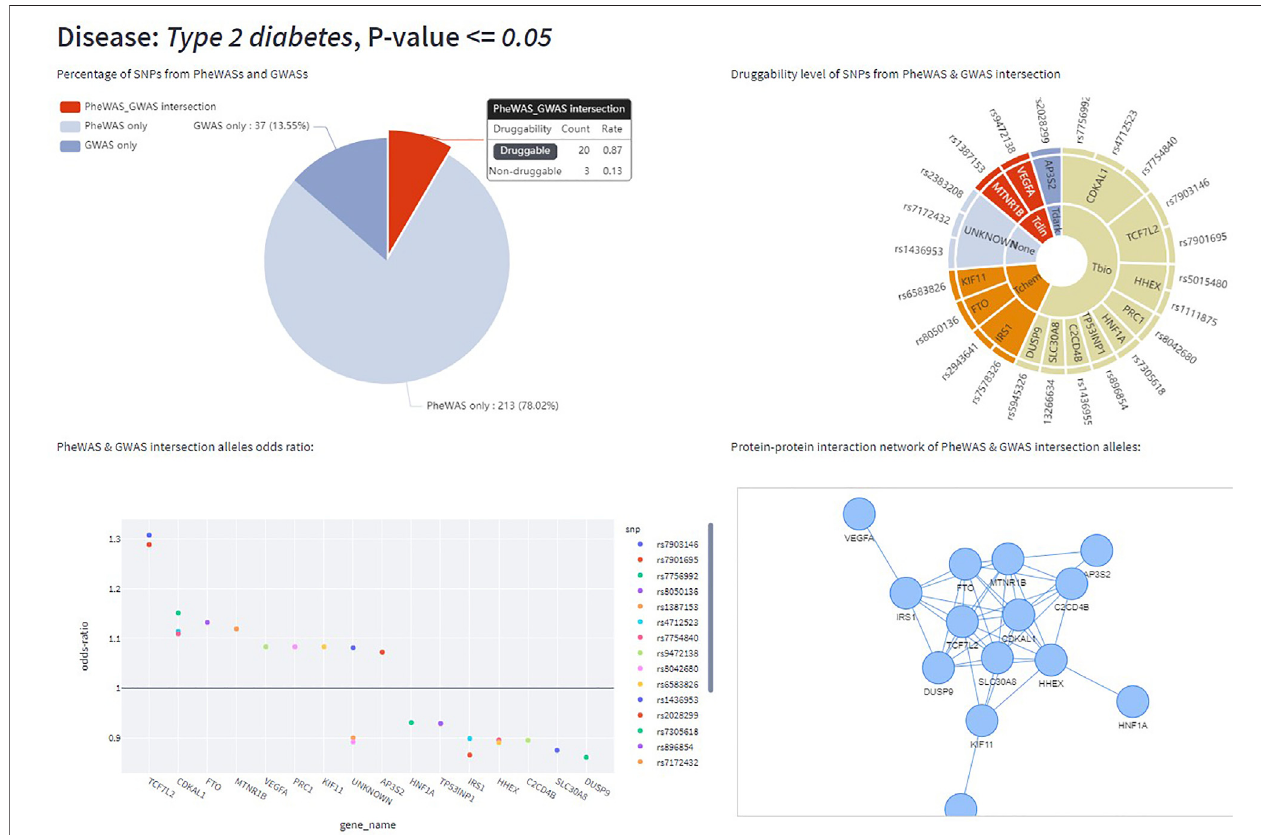
FIGURE 4 | The StarGazer interface after searching “ Type 2 diabetes ” in GWAS-PheWAS Intersection mode. At p = 0.05, 23 SNPs were identi fi ed to have associations in both PheWASs and GWASs. Top left: pie chart displaying the proportion of SNPs that were identi fi ed in either PheWAS or GWAS datasets, or in both datasets.Topright:piechartdisplayingdruggabilityinformationofthegenesoftheseSNPs.Tclininredimpliesgenesalreadyhavedrugstargetingthemavailableonthe market, whilst Tchem, Tbio, Tdark, and None, indicate progressively decreasing levels of druggability. Bottom left: scatter plot highlighting individually reported odds-ratios of associations of SNPs from various GWASs. Bottom right: a protein-protein interaction network constructed from the genes of alleles detected in both GWASs and the PheWAS catalog. The gene ontology enrichment analysis feature is not shown in the fi gure.